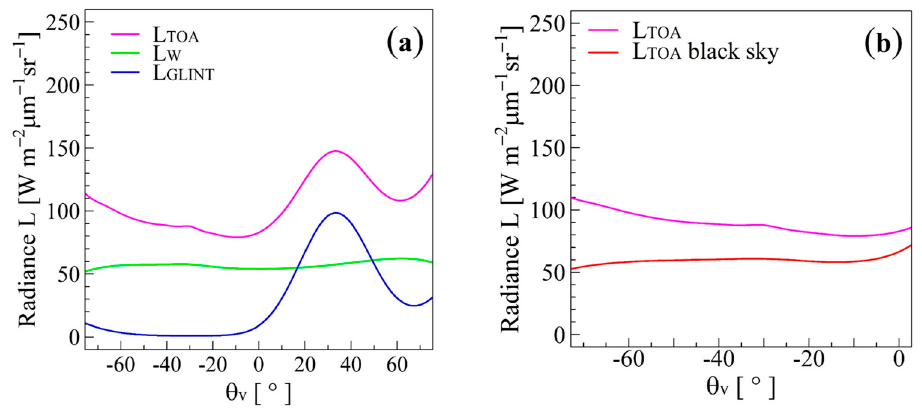
Figure 1. ( a ) Variation of the top of atmosphere radiance L TOA , of the water leaving radiance L w and of the glint radiance L glint (in W m − 2 µ m − 1 sr − 1 ) as a function of the viewing zenith angle θ v . The simulations are carried out at 560 nm using the benchmark parameters listed in Table 1. The results are shown in the principal plane observation geometry. Note that positive values of the viewing zenith angle θ v are used for the specular half-plane ( ϕ OSOAA = 0 ◦ ) and negative values are used for the backscattering half-plane ( ϕ OSOAA = 180 ◦ ); ( b ) Comparison of the top of atmosphere radiance L TOA between the benchmark case of simulation and the same case except the atmospheric scattering processes are removed (black sky); results are shown in the backscattering half-plane only ( θ v <0).